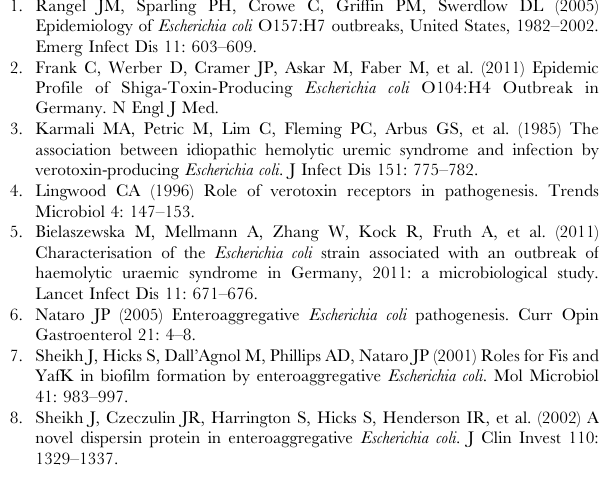
Table S1 Fold-change differences in gene expression in germ-free mice infected with E. coli O104:H4 seven days post infection relative to E. coli O104:H4 in vitro growth. Table S2 Fold-change differences in gene expression in germ-free mice infected with E. coli O104:H4 at 7 days post infection relative to mice infected with E. coli O157:H7 at 5 days post infection. Table S3 Fold-change differences in E. coli O104:H4 gene expression in vivo 13–14 days post infection as compared to seven days PI and acute tubular necrosis (ATN) scores. Table S4 Relative differences in E. coli O104:H4 gene expression in vivo 13–14 days post infection as com- pared to growth in vitro . Table S5 Primers used for quantitative